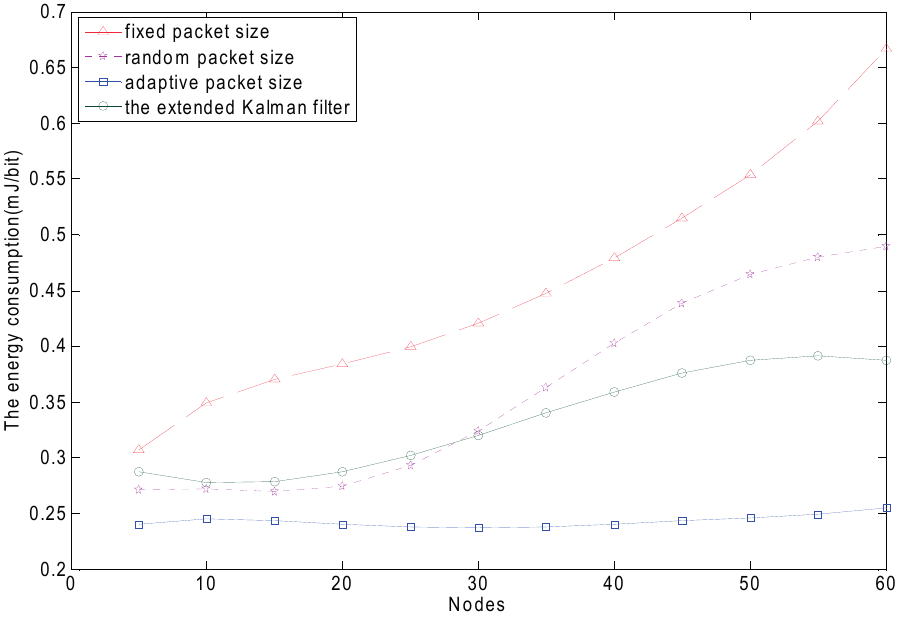
Figure 16. The energy consumption comparison of the different packet size schemes per number of mobile nodes.